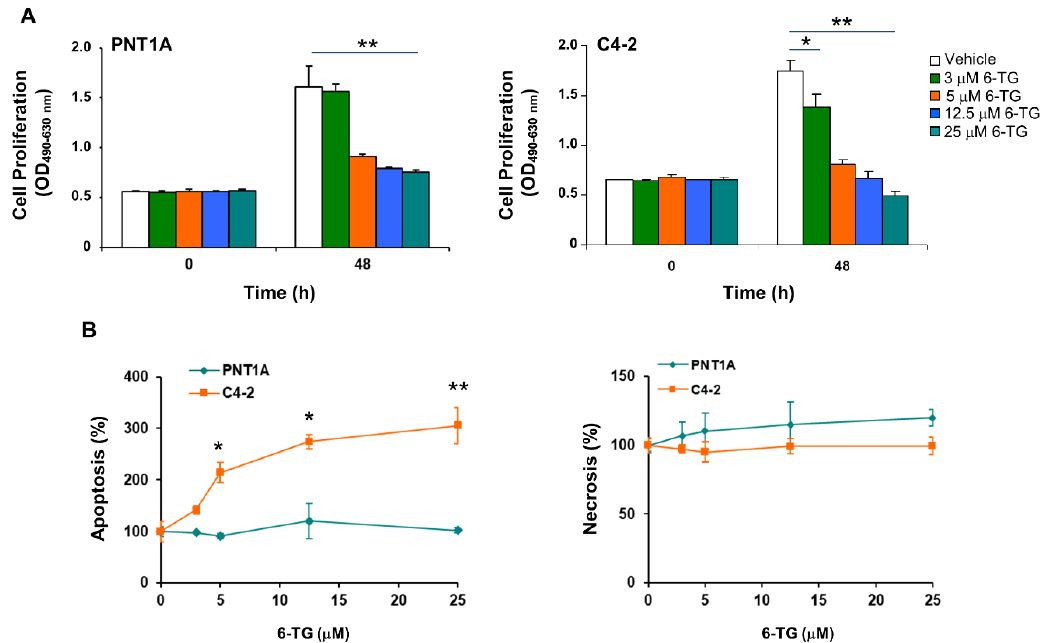
Figure 3. 6-TG promotes apoptosis in cancer but not in normal prostate cells. ( A , B ) Prostatic Normal large T-antigen Immortalized 1A (PNT1A) and C4-2 cells were treated with different concentrations of 6-TG for 48 h. ( A ) Cell proliferation was measured by 2,3-bis-(2-methoxy-4-nitro-5-sulfophenyl)-2H-tetrazolium-5-carboxanilide (XTT) assay. Each point represents the mean ± SD from cells of triplicate wells. The experiment was repeated three times. ( B ) Cell apoptosis and necrosis were assessed by measuring mono- and oligo-nucleosomes in the cytosol and culture medium, respectively. Each point represents the mean ± SD from cells of triplicate wells. The experiment was repeated three times. * p < 0.001; ** p < 0.0001.